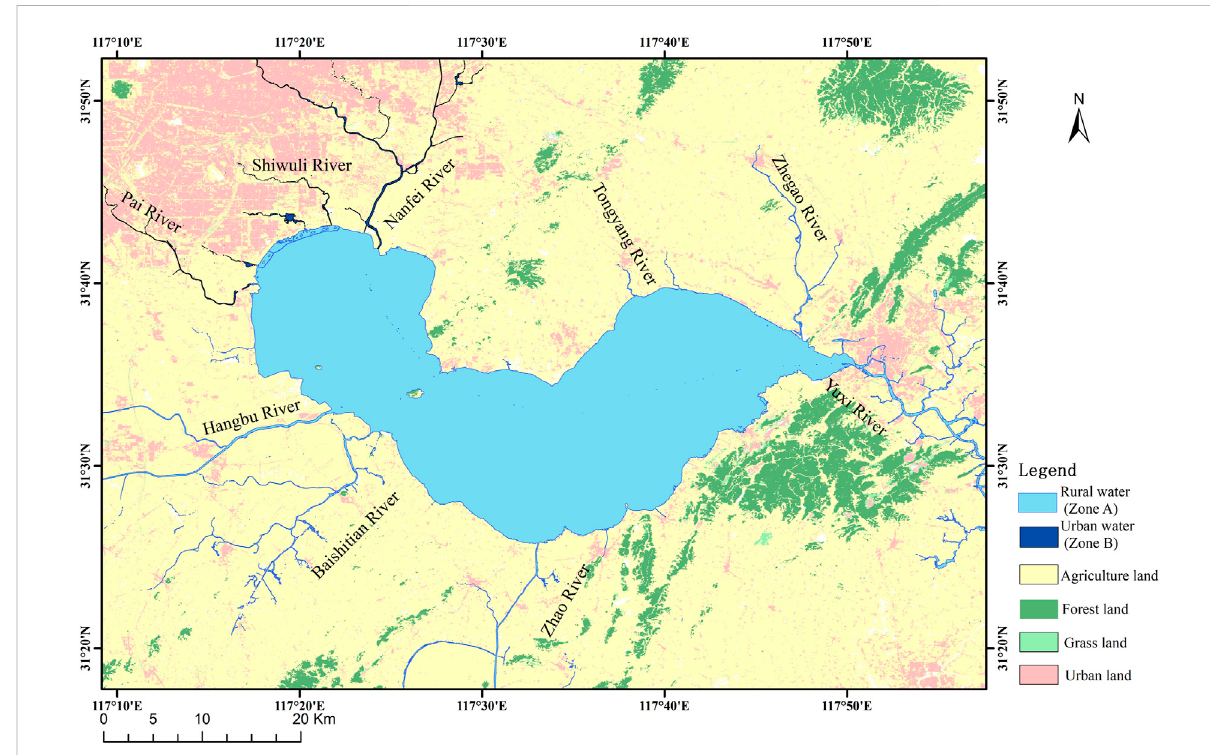
FIGURE 3 Geographical division of the study area according to land-type proportions in the riparian zones.